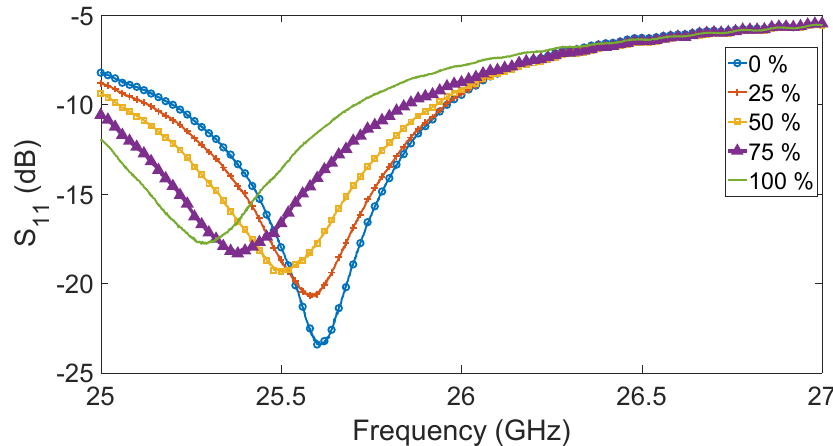
Figure 6. S 11 of the antenna immersed in a solution of ethanol and water with different concentrations: 0% (blue solid line with circles), 25% (orange solid line with plus signs), 50% (yellow solid line with squares), 75% (purple solid line with triangles), and 100% (green solid line without markers).